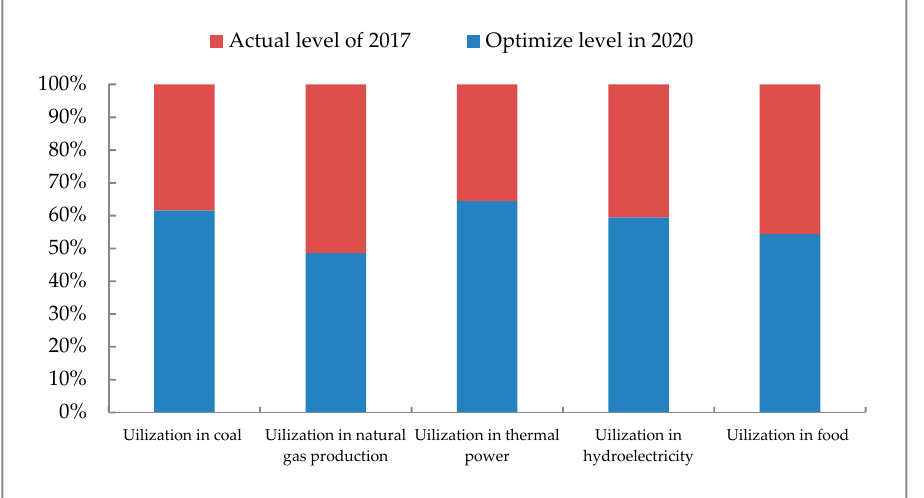
Figure 5. Comparison chart of water resources utilization between horizontal year and planned year.